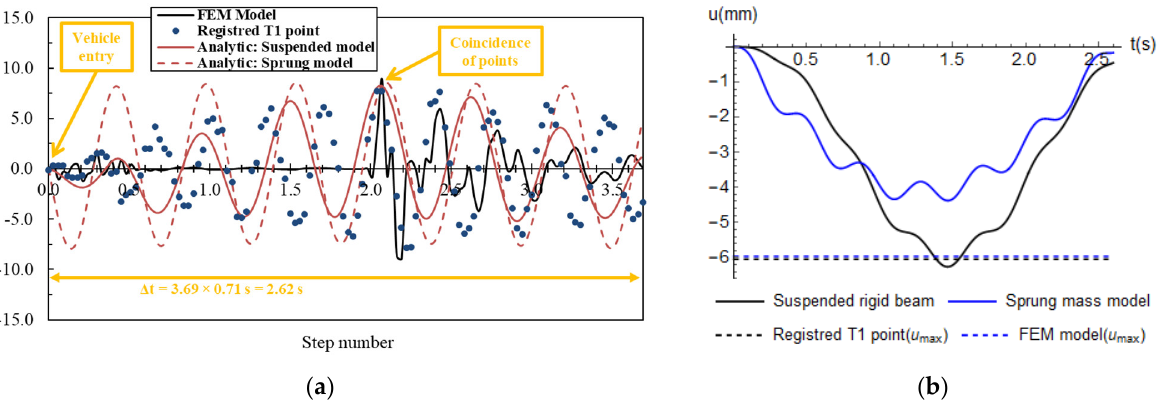
Figure 10. Bridge response in terms of vertical accelerations: ( a ) calibration between all models; ( b ) results. The used data are shown in Tables 1–3 with v = 16.0 m/s (≈ 60.0 km/h).